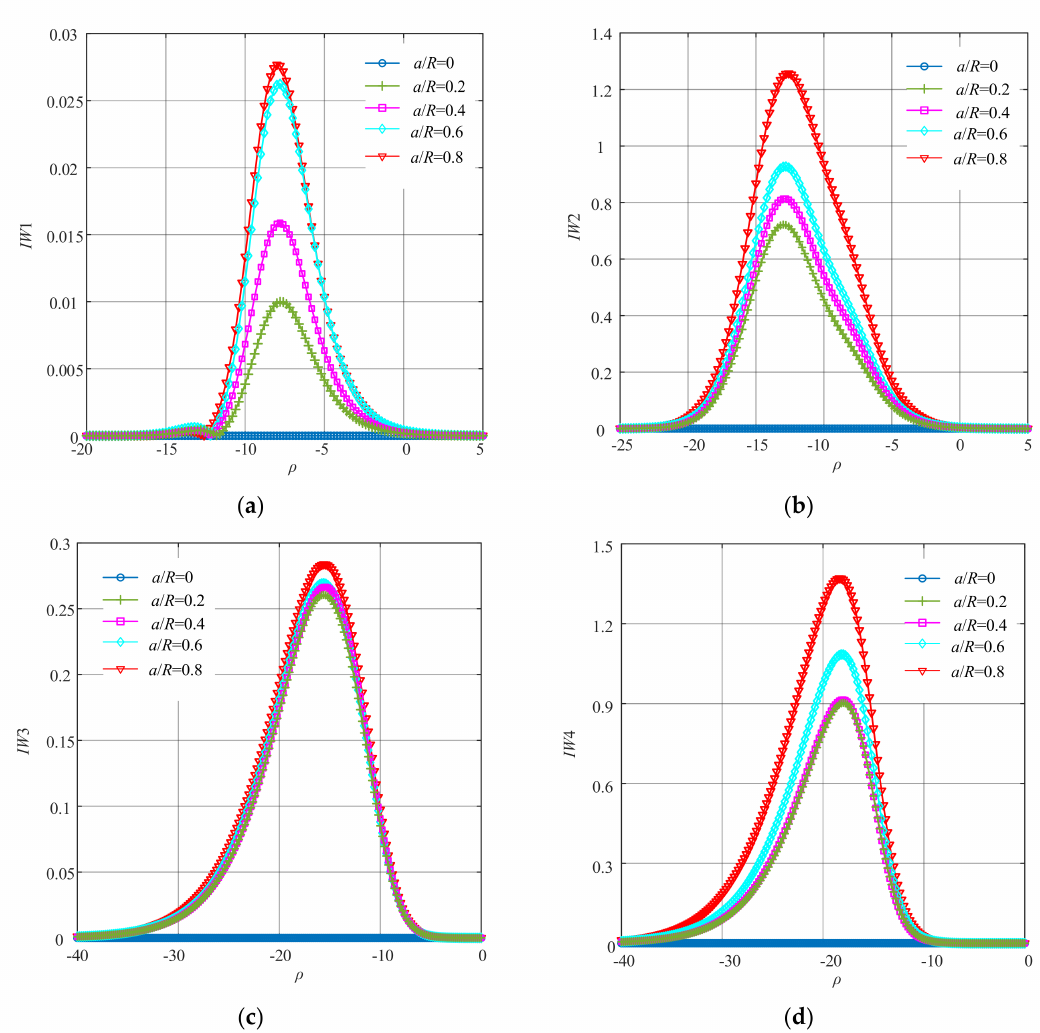
Figure 13. The curves of each order of improved WNOFRFs under different crack faults in the